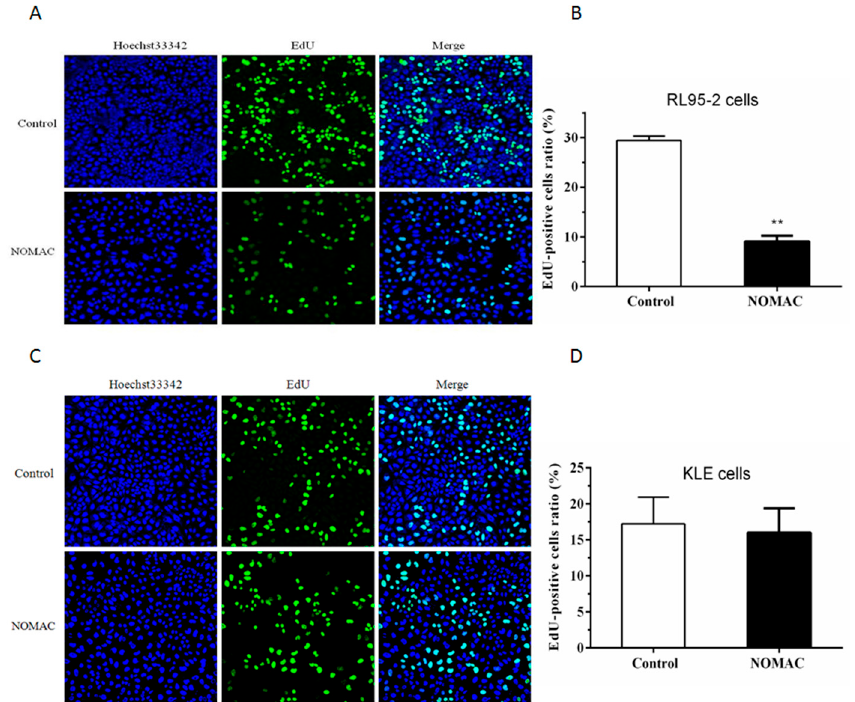
Figure 2. Effects of NOMAC on the cell lines of RL95-2 and KLE. All cell nuclei show blue fluorescence indicative of Hoechst33342 staining. EdU-labeled cells (green fluorescence) indicate new DNA synthesis following NOMAC (20 μ mol/L) or DMSO treatment for 48 h (original magnification, 200×). All of the results that come from three independent experiments and are expressed as mean ± SD. ( A , B ) The relative ratio of EdU-positive RL95-2 cells is lower in the NOMAC group than in the control group at 48 h ( p < 0.01); ( C , D ) the relative ratio of EdU-positive KLE cells is slightly low in the NOMAC group than the control group ( p > 0.05). These results were typical of three independent experiments. ** p < 0.01 vs. control.